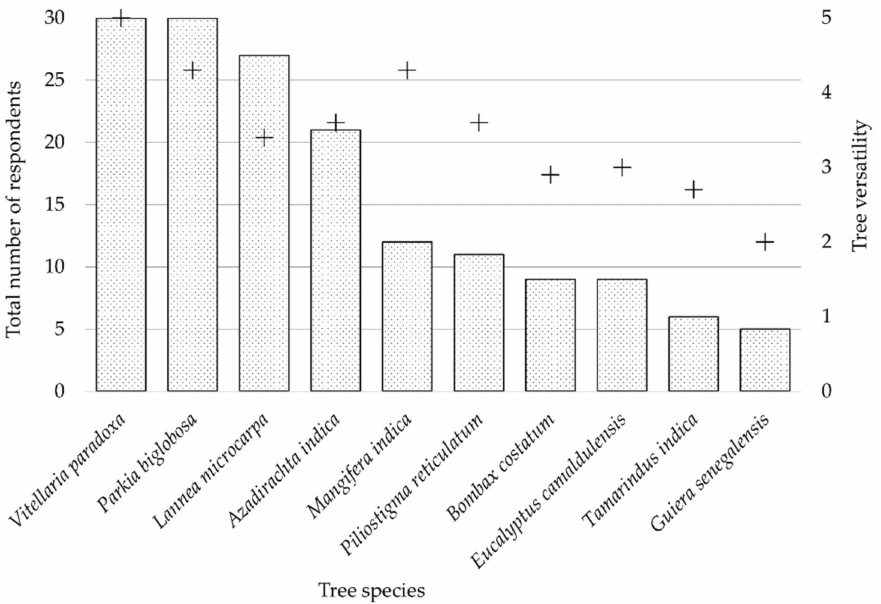
Figure 5. The 10 top-ranked species of trees preferred by survey respondents and the versatility of each species. Bars indicate the number of respondents, “+” indicates the tree